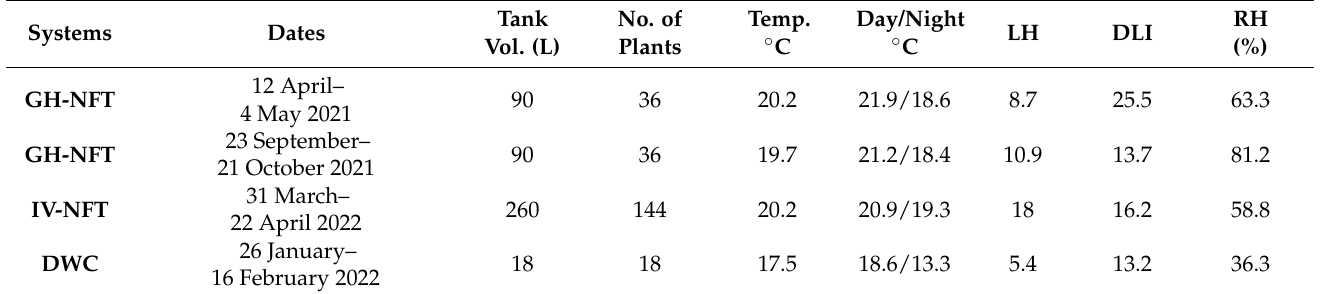
Table 1. The growth conditions in different hydroponic